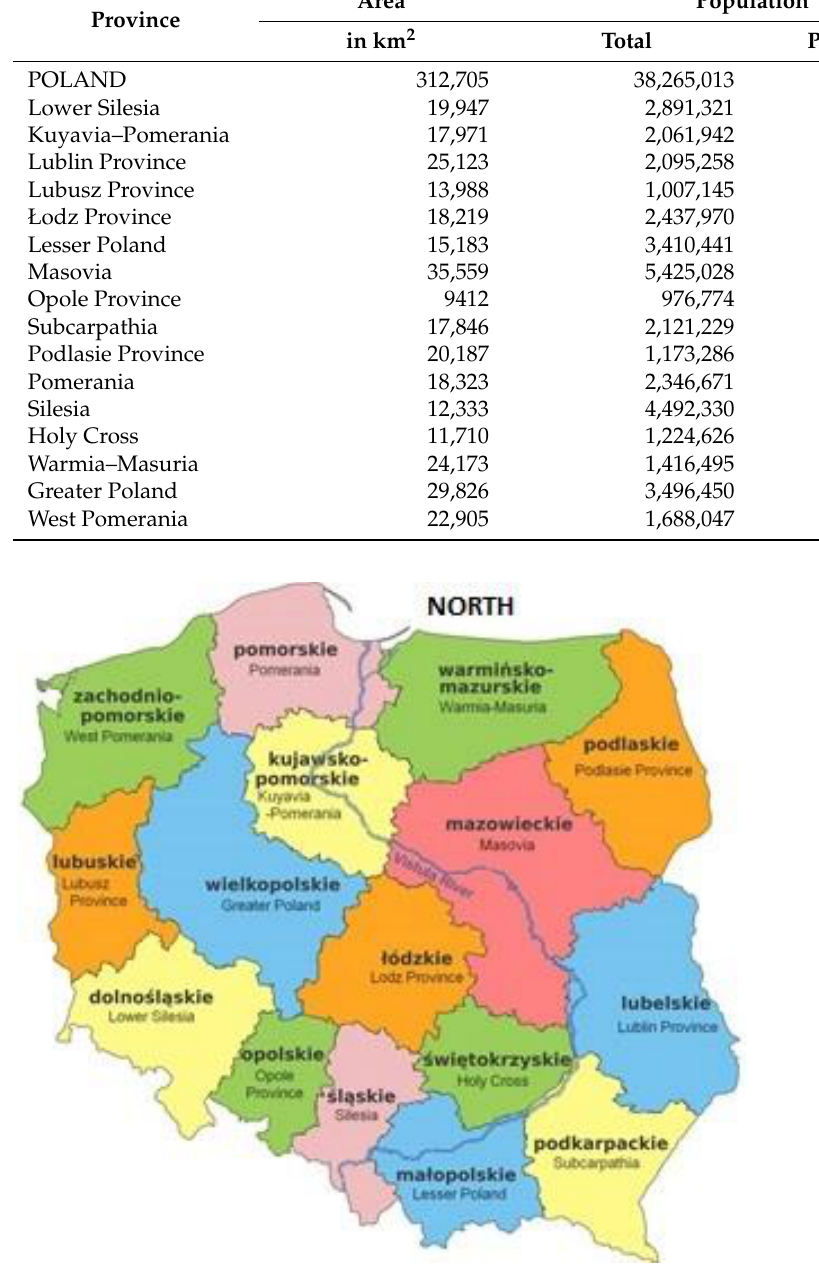
Figure 2. Location of provinces in Poland [62]. Scale: 1:1,000,000.